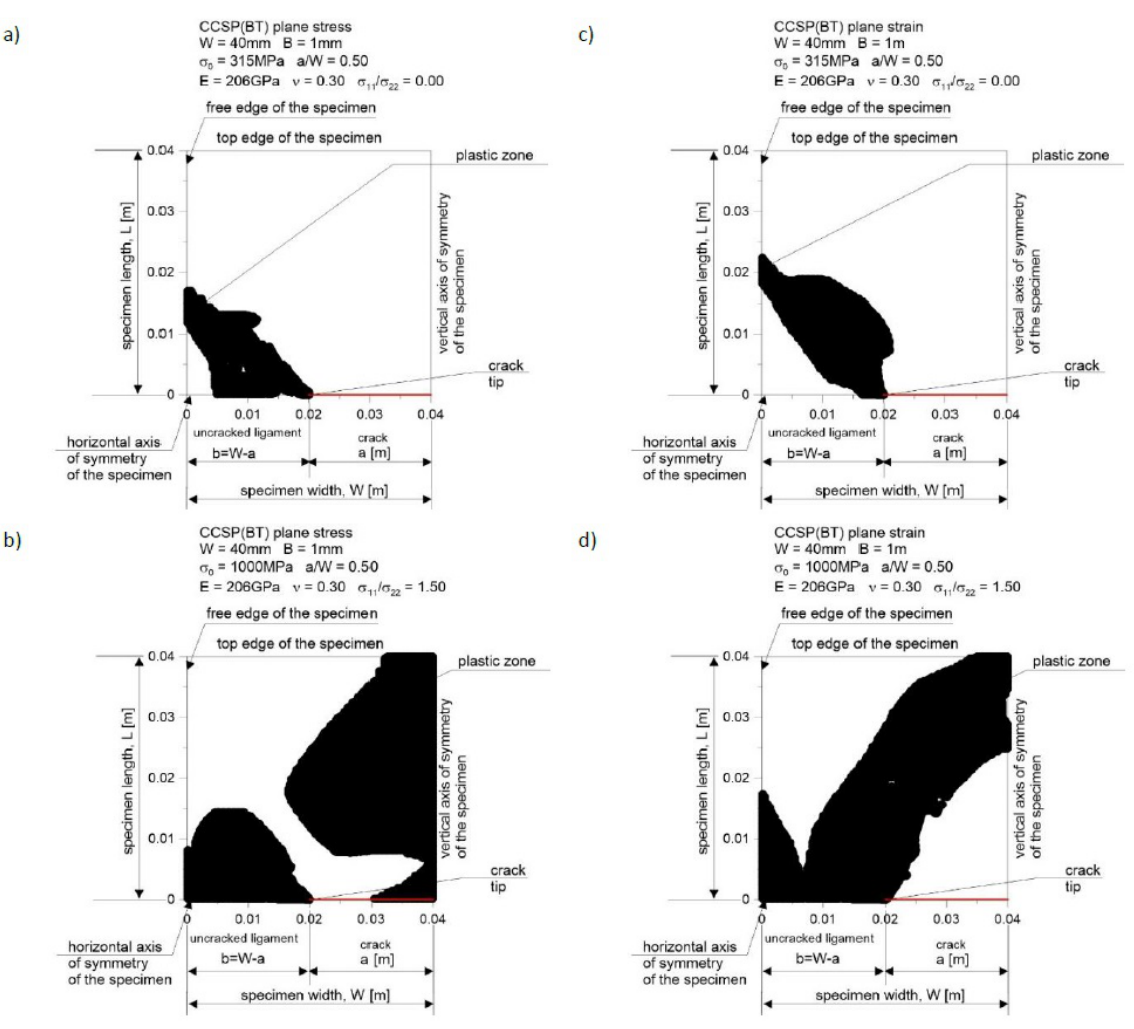
Figure 12: Shape of the plastic zones in the CCSP(BT) with the same crack length and extreme values of the ratio of tensile stresses σ 11 / σ 22 : a) σ 11 / σ 22 = 0, plane stress state; b) σ 11 / σ 22 = 1.50, plane stress state; c) σ 11 / σ 22 = 0, plane strain state [12]; d) σ 11 / σ 22 = 1.50, plane strain state